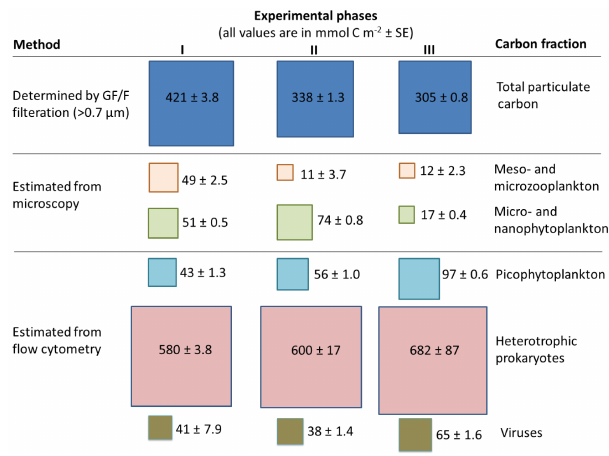
Figure 1. The different fractions of carbon in the control meso- cosms (M1 and M5) at the start of phases I ( t0 ), II ( t17 ), and III ( t31 ), in mmolCm − 2 ± SE ( n = 2). The differences between the controls and elevated CO 2 concentration are discussed in the text. The size of the boxes indicates the relative size of the carbon stand- ing